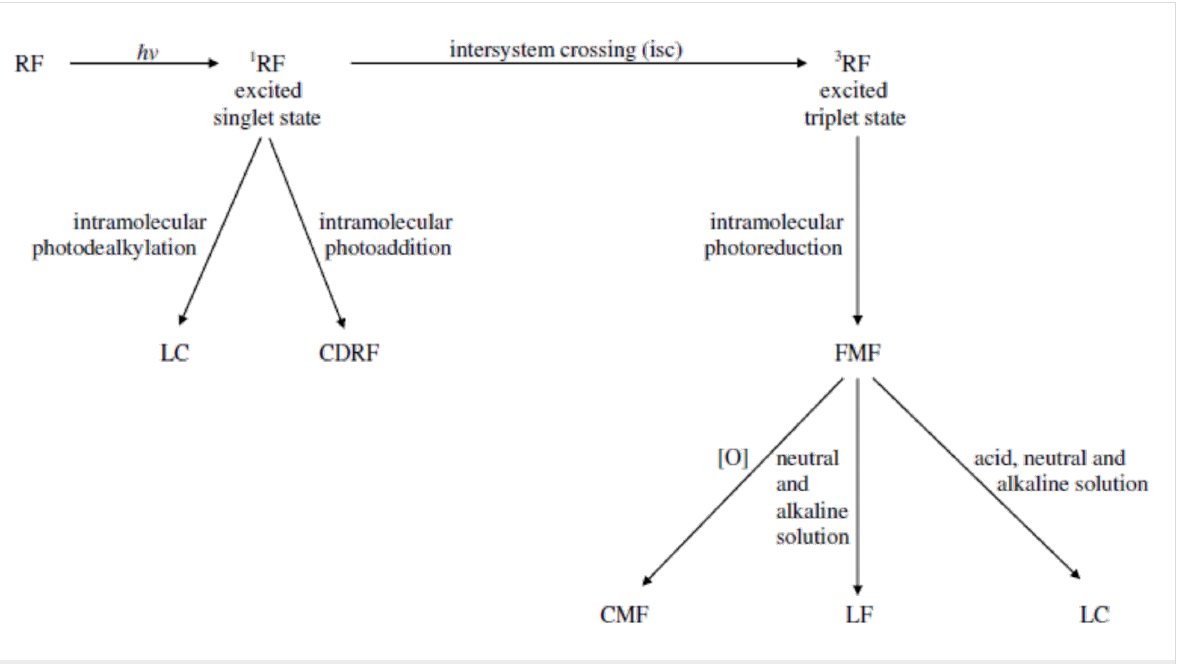
Figure 2: A general scheme for the photodegradation of RF in aqueous